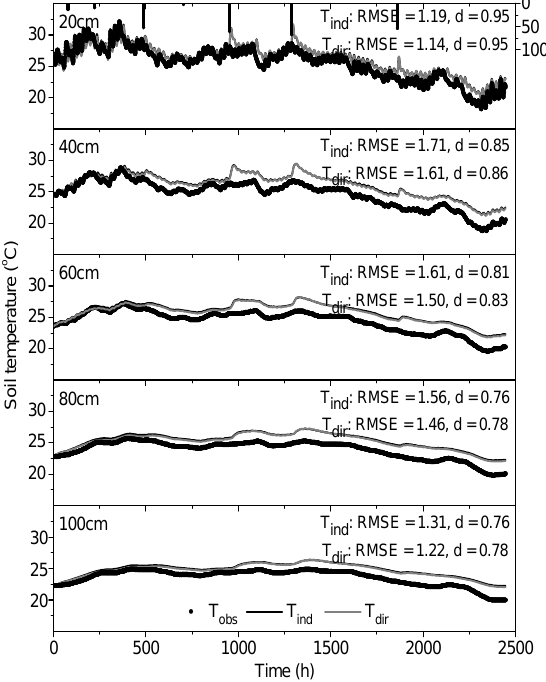
Figure 5. Comparison of observed and simulated soil temperature, at selected depths: 20, 40, 60, 80, and 100cm, with measured pre- cipitation and irrigation. The black dots represent the observation, the solid black line shows the simulation with the ET ind method, and the solid gray line shows the simulations with the ET dir